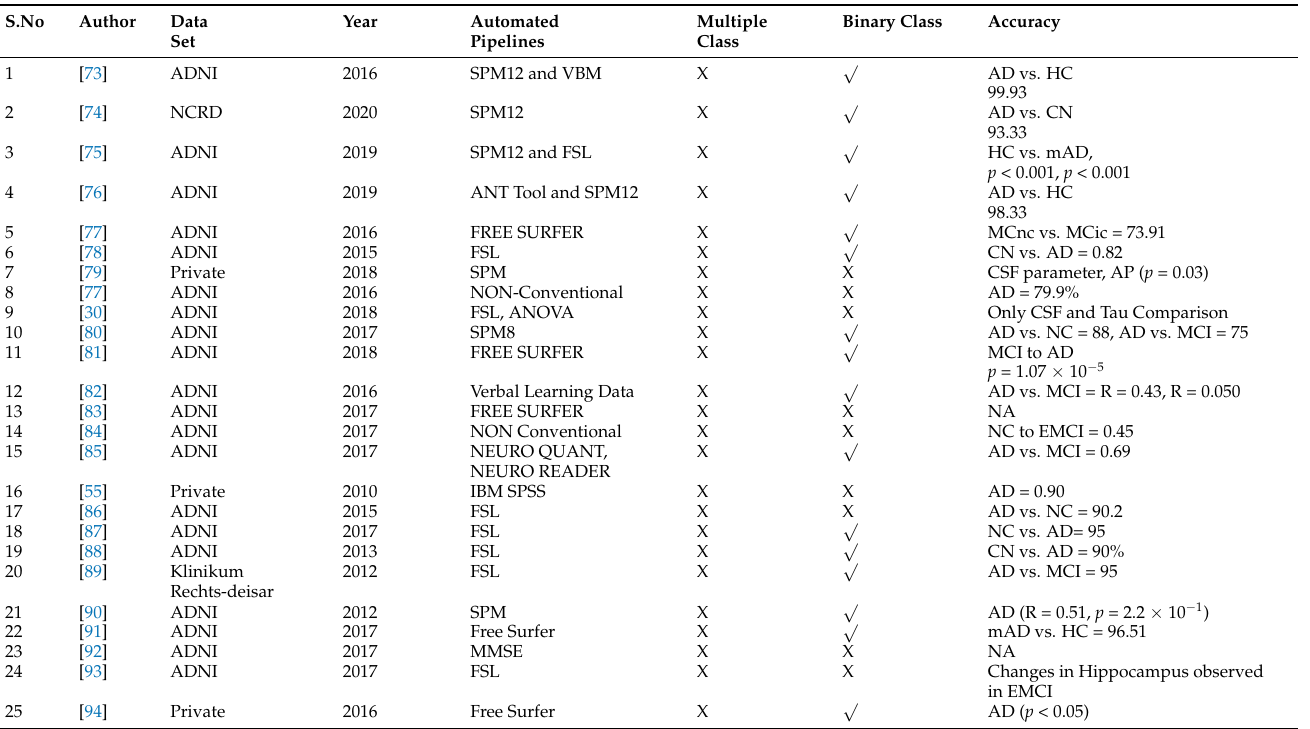
Table 5. Analysis of the Automatic Pipelines for AD detection in the Single, Binary and Three or more class classification.